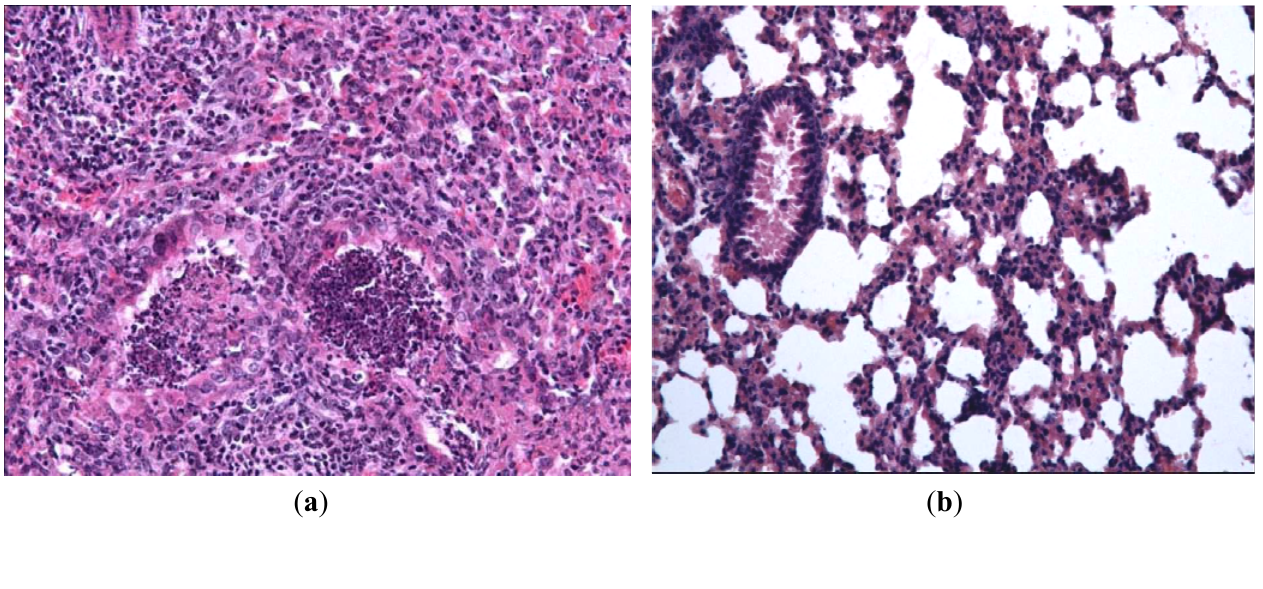
Figure 3. Pathologies of mice intranasally inoculated with mouse-adapted influenza virus A/California/7/09 (H1N1)v on day 3 p.i. ( a ) Lungs of a placebo-treated mouse. Large area of pneumonia with intense exudates in bronchial lumen, severe neutrophilic-to-histiocytic alveolitis; ( b ) Mild lymphocytic peribronchitis with mild alveolitis in a mouse treated with 30 mg/kg body weight of ingavirin. Cells of bronchial epithelium are intact, mild exudates in bronchial lumen; ( c ) Mild lymphocytic peribronchitis with alveolitis in a mouse treated with 20 mg/kg oseltamivir; ( d ) Lungs of intact mice. No signs of inflammation or cell destruction. Hematoxylin-eosin,